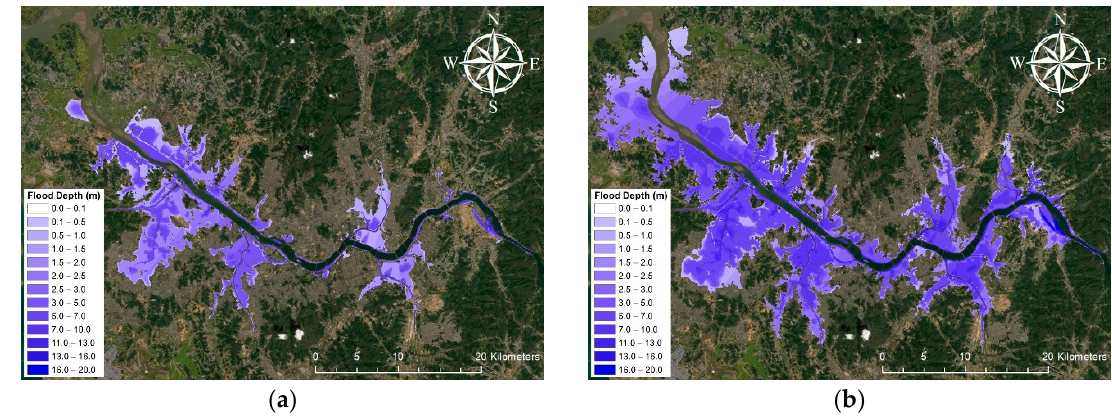
Figure 7. Flood map calculation using DAMBRK and the GIS program. ( a ) 500 y; ( b ) PMF (dam-break).